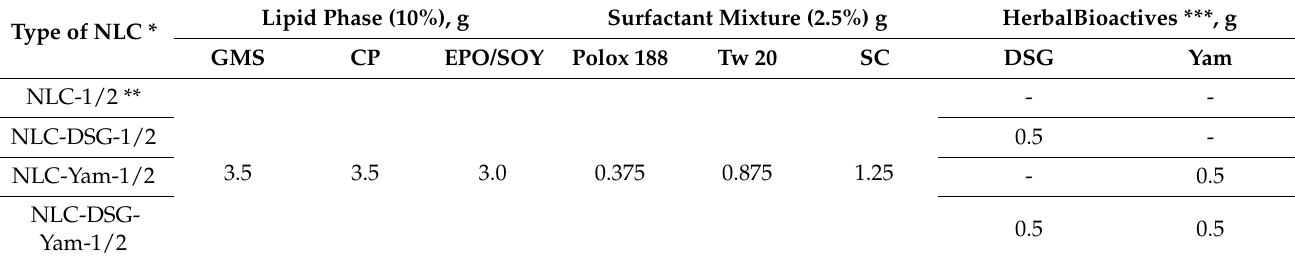
Table 1. Composition of nanostructured aqueous dispersions encapsulating Diosgenin and/or wild yam extract. Lipid Phase (10%), Type of NLC *